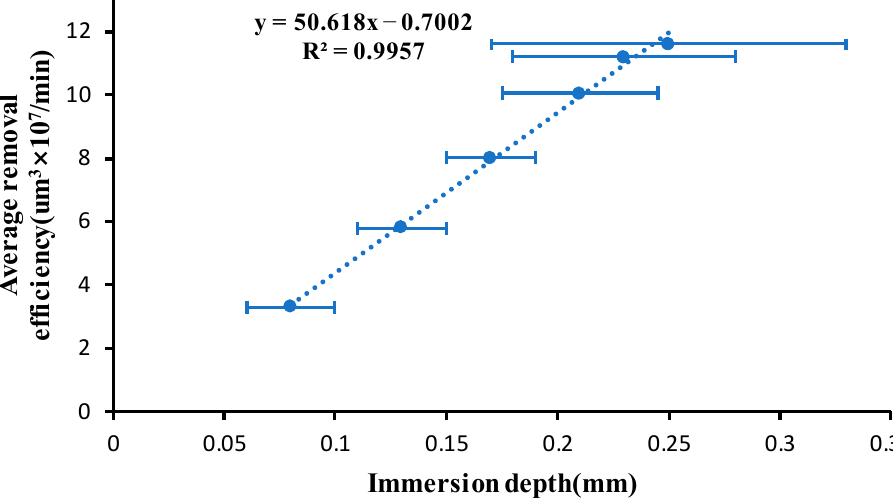
Figure 4. Relationship between average immersion depth and volumetric removal